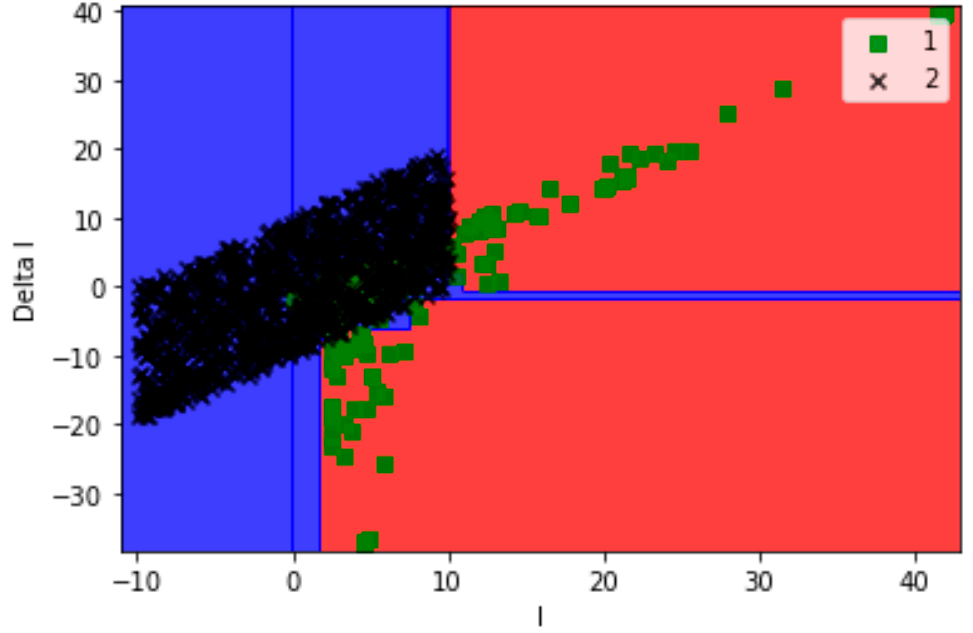
Figure 9. The locations of the testing dataset on the regions of the real and fake data. Table 2. Sample of decision tree selection based on the probability of events.